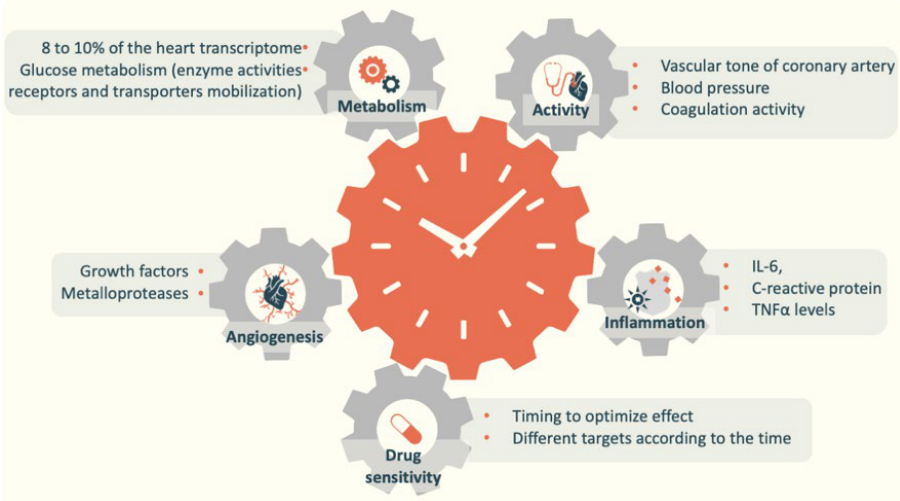
Figure 2. Essential parameters of cardiovascular physiology displaying circadian rhythms.